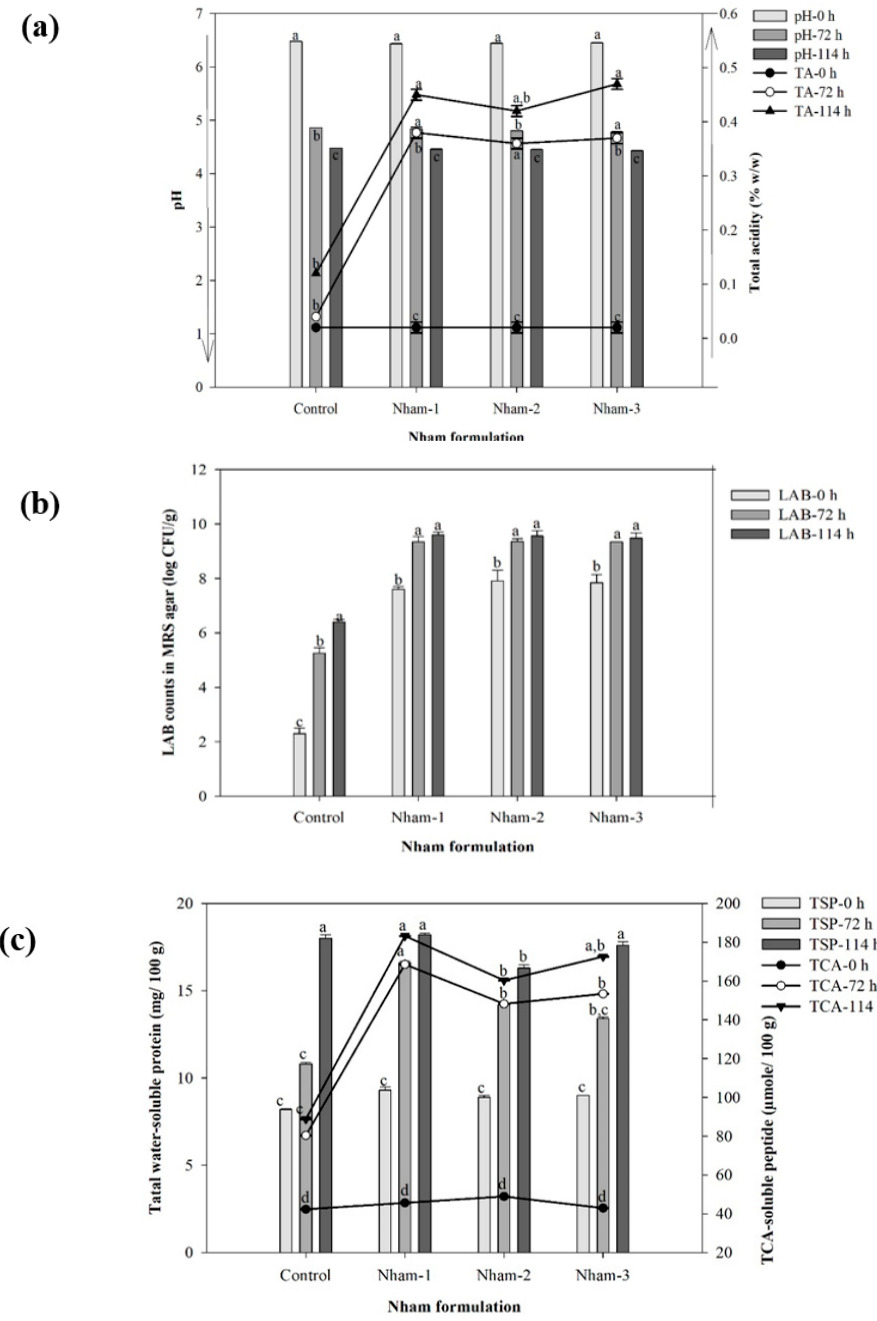
Figure 2. The co-relationship between physicochemical and microbiological characteristics of the changes in pH and TA ( a ), and ( b ) LAB counts during each Nham probiotic fermentation with different Lactobacillus sp. Mean values ± SD ( n = 3) of different Lactobacillus sp. with different letters ( a – c ) for their properties during fermentation time.